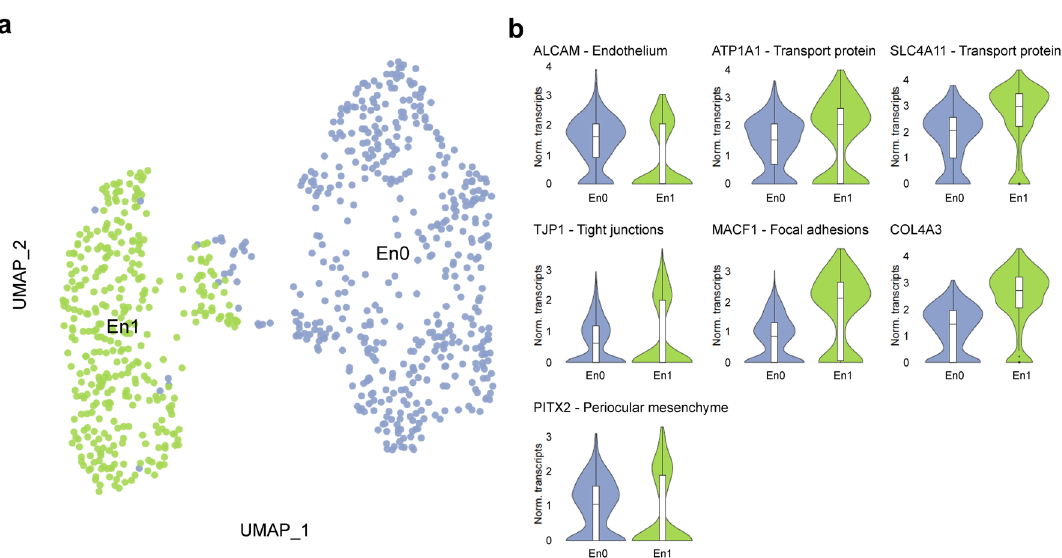
Figure 6. A major cluster of 842 corneal endothelial cells was identified with scRNAseq analysis. The UMAP revealed two different endothelial cell subclusters, a cell cluster with high collagen synthesis (En1) and another cell cluster with low tight junction and focal adhesion protein expression (En0) ( a ). Violin plots show marker genes for corneal endothelium ( ALCAM ), ion and bicarbonate transporters ( ATP1A1 and SLC4A11 respectively), tight junction proteins ( TJP1 ), focal adhesion protein regulator ( MACF1 ), collagen secretion ( COL4A3 ) and periocular mesenchyme ( PITX2 ) ( b